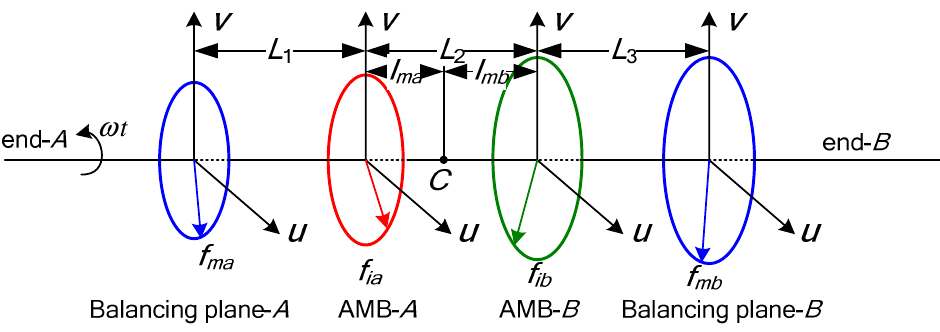
Figure 8. Schematic of the double-plane balancing